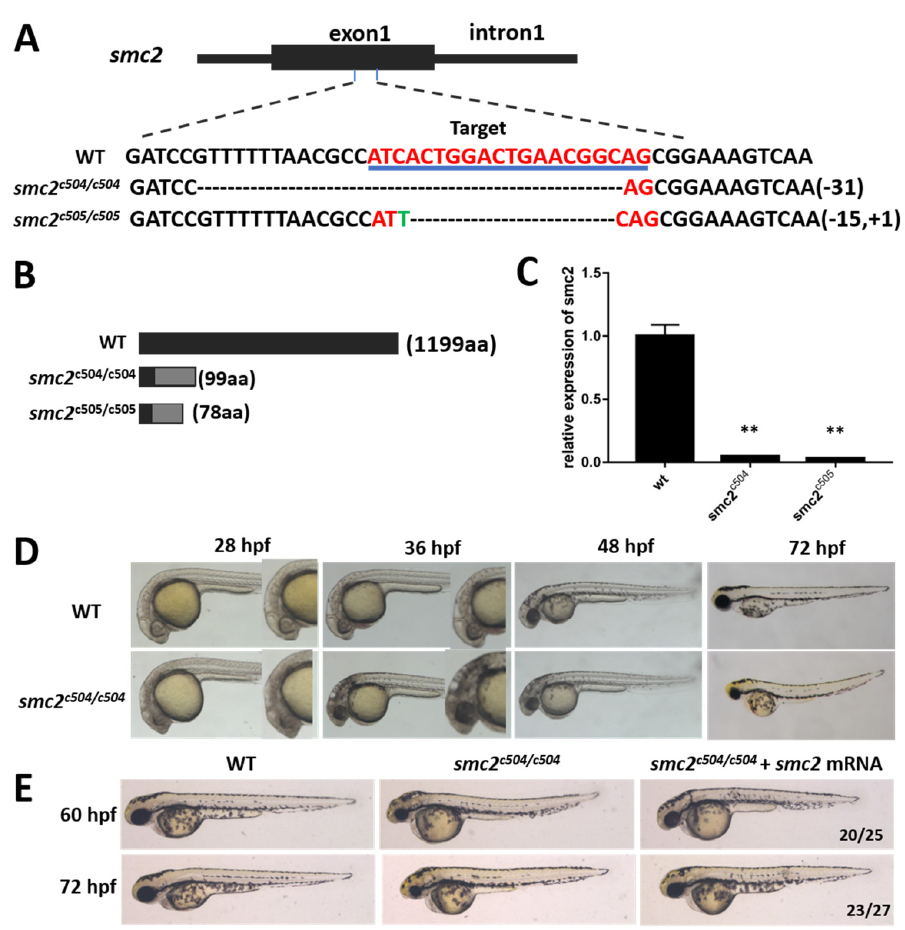
Figure 2. ( A ) Top panel: the schematic diagram shows the structure of the target region in the SMC2 gene. Black box, exon; solid line, introns. The bottom panel shows a comparison of the genomic DNA sequences among WT and two mutant alleles, SMC2 c504/504 mutants carrying a 31-bp deletion and SMC2 c505/505 mutants carrying a 15-bp deletion and 1-bp insertion. The target sequence is indicated in red and underlined. ( B ) Schematic structures of WT and truncated SMC2 proteins. ( C ) The relative mRNA levels of SMC2 in WT and homozygous mutants were assayed by qPCR at 4 dpf. The results are expressed as the mean ± SD of three independent experiments (**, p < 0.01; t -test). ( D ) Lateral views showing the morphology of WT and SMC2 − / − mutants at 28, 36, 48 and 72 hpf. ( E ) Morphology of WT and SMC2 − / − embryos injected with or without 200 pg SMC2 -mRNAs at indicated stages. The smaller eyes and smaller head were significantly reduced in SMC2 -mRNA-injected mutant embryos. The ratios at the bottom right corners indicate the number of embryos with indicated phenotypes vs. total number of observed embryos.